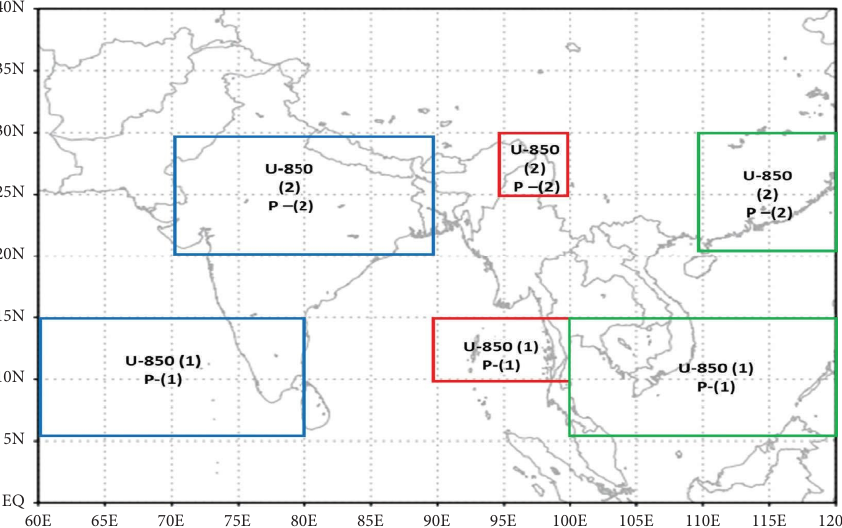
Figure 5: Typical monsoon circulation indices schematic diagrams: the ISM index (blue solid boxes), the MSwM CP index (red solid boxes), and the WNPM index (green solid boxes) were adopted from [13].